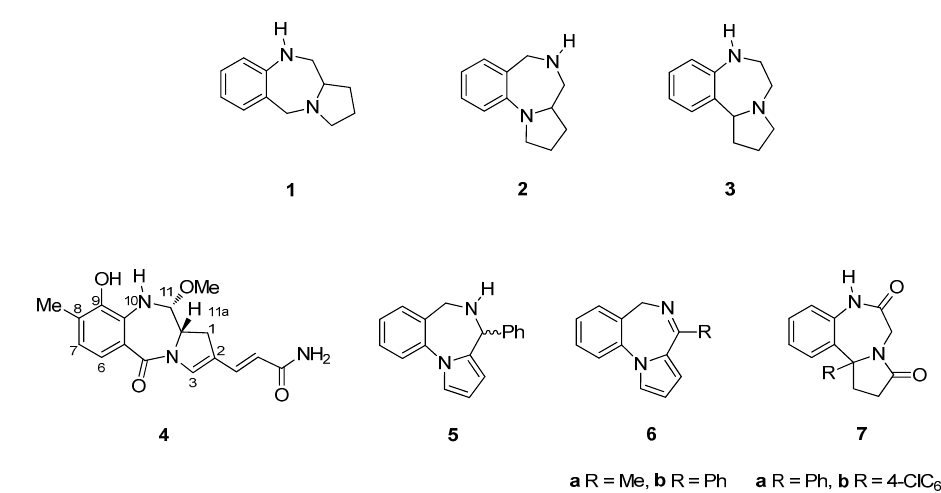
Figure 1. Structure of the three pyrrolo[1,4]benzodiazepine isomers 1 – 3 and the first derivatives 4 – 7 .